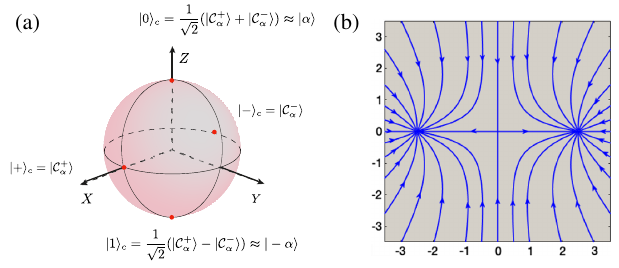
p FIG. 1. (a) Bloch sphere representation of a cat qubit. (b) Vector ffiffiffiffiffiffiffiffiffiffiffiffiffiffi ϵ 2 ph =K